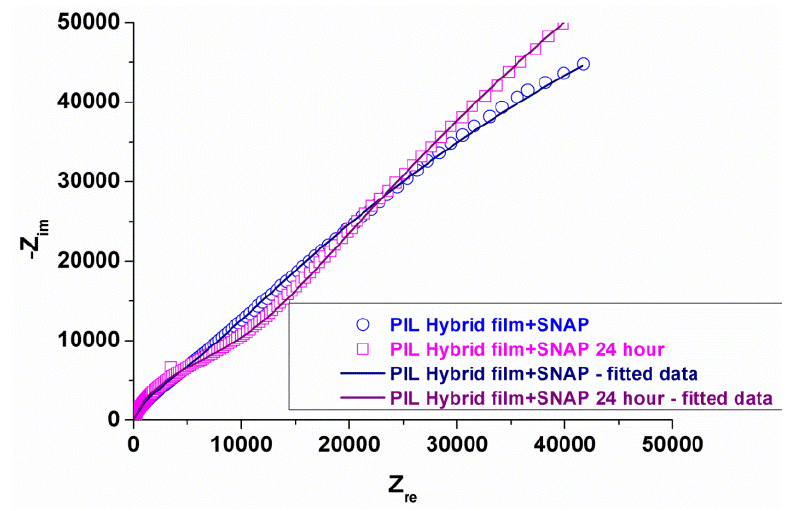
Figure 10. Nyquist plot and modelling result of the impedance data for PIL hybrid film/SNAP coated samples. Table 2. Resistance and capacitance values obtained from EIS modelling (using the model in Figure 9). SAMPLE